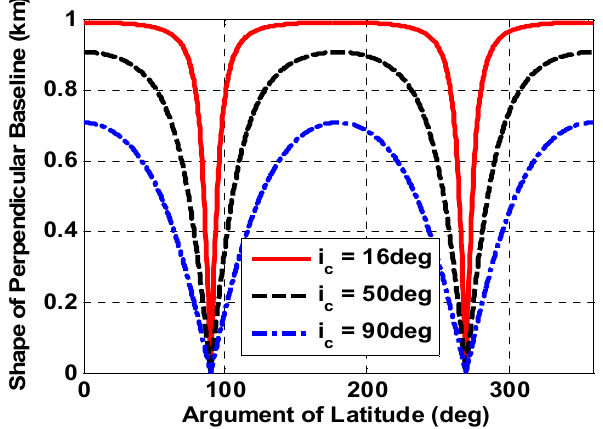
Figure 5. Shape of perpendicular baseline for different inclinations in GEO SAR.